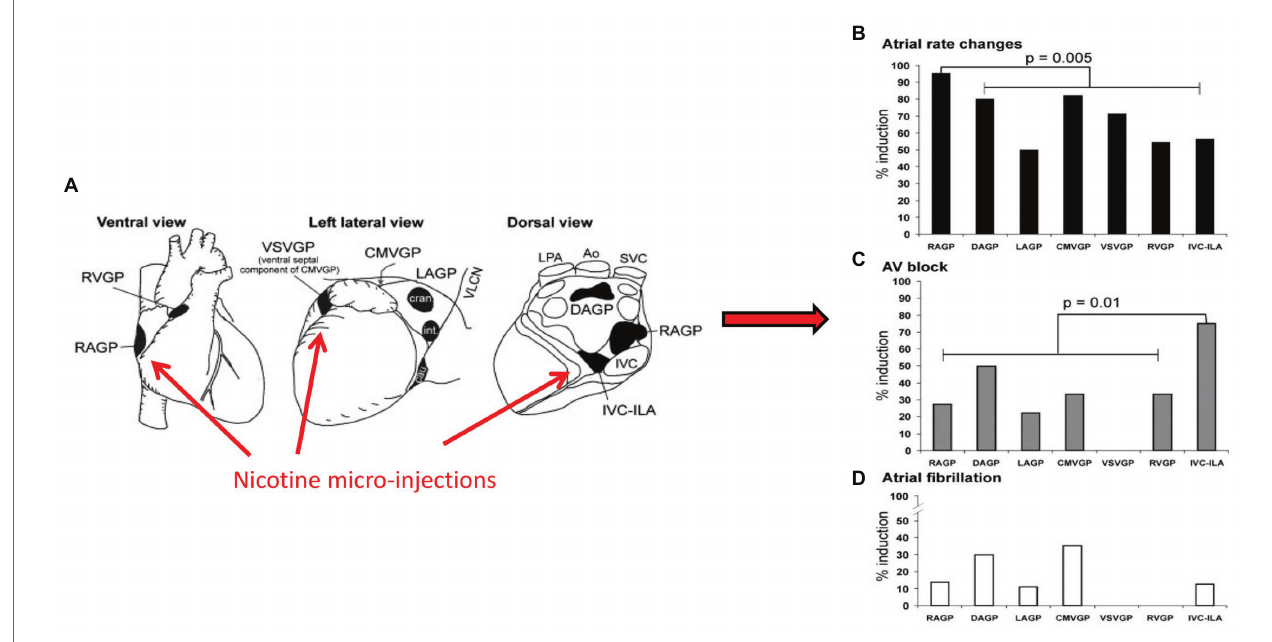
FIGURE 4 | Aggregates of afferent, efferent, and interneurons located within epicardial fat pads comprise the ICNS. Although each ganglionated plexus has a preferred sphere of influence, substantial overlap exists. (A) Ventral, left lateral and dorsal views of the heart demonstrating common atrial and ventricular ganglionated plexi. Selected electrophysiologic effects of nicotine microinjections into major atrial and ventricular ganglionated plexi, (B) Heart rate, (C) Atrioventricular block, (D) atrial fibrillation. RVGP, right ventricular ganglionated plexus. RAGP, right atrial ganglionated plexus. VSVGP, ventral septal ventricular ganglionated plexus. CMVGP, cranial medial ventricular ganglionated plexus. LAGP, left atrial ganglionated plexus. DAGP, dorsal atrial ganglionated plexus. IVC-ILA, inferior vena cava-inferior atrial ganglionated plexus. Adapted from Cardinal et al. (2009) with